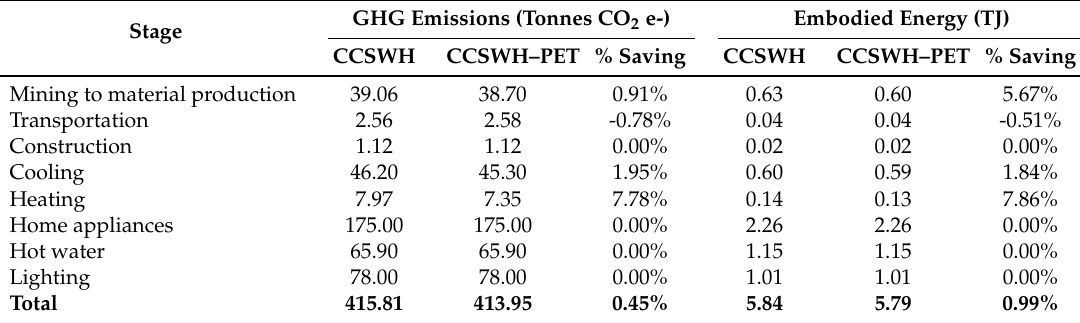
Table 5. Breakdown and comparison of GHG emissions and embodied energy consumption in terms of inputs for CCSWH, and CCSWH with PET